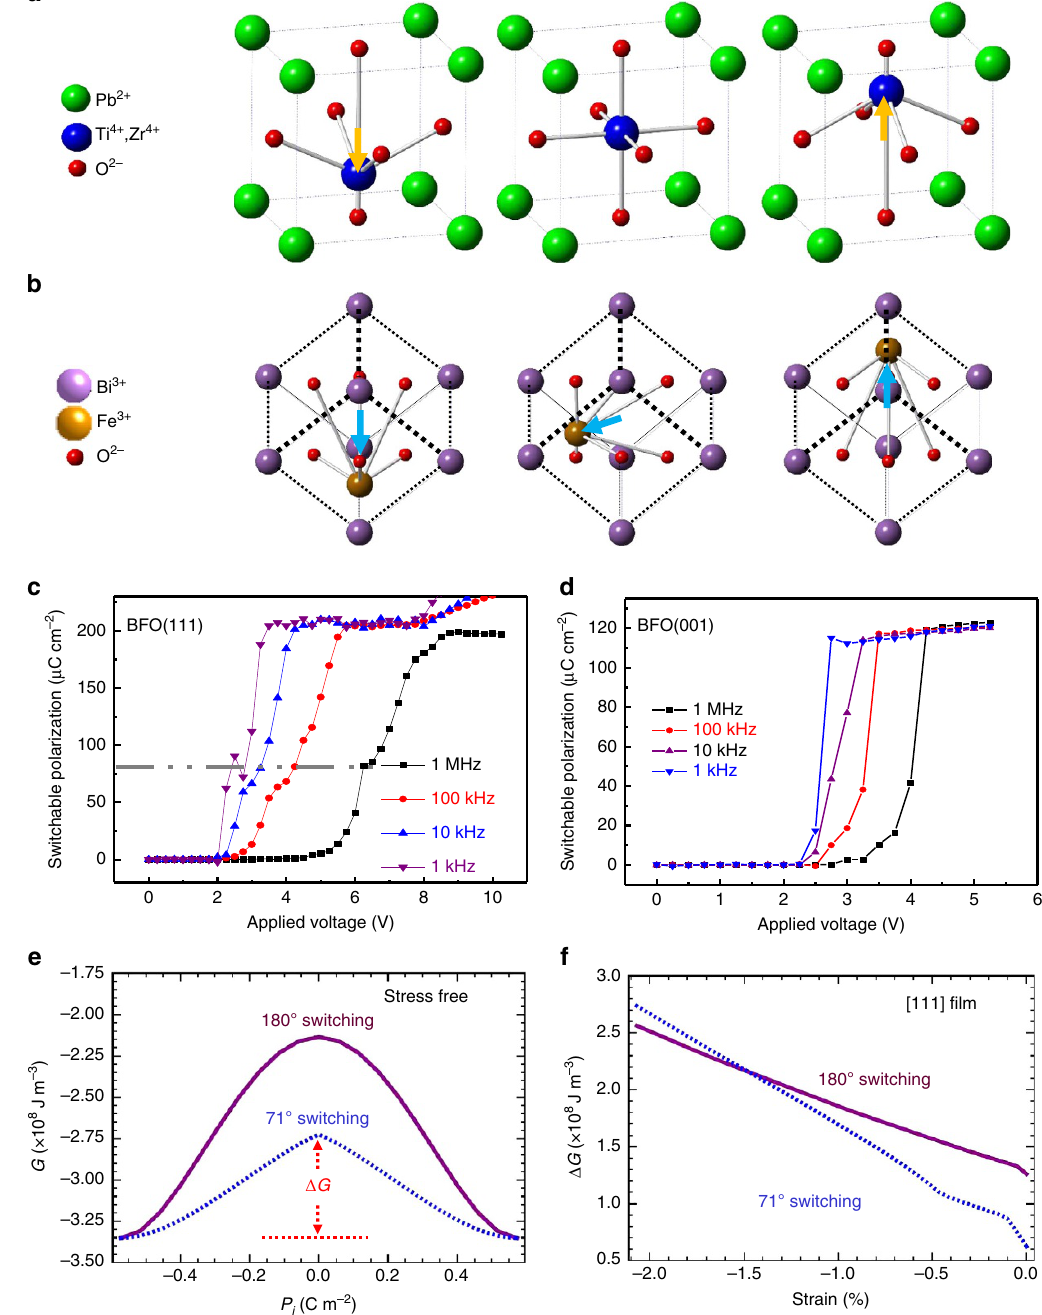
Figure 1 | The processes of polarization switching and simulation of the effect of strain to polarization switching. Schematic diagrams of polarization switching process for ( a ) PZTand ( b ) BFO(111), and the polarization–electric field PE loops for ( c ) BFO(111) and ( d ) BFO(001). ( e ) Total free energy as a function of switching path under stress-free boundary conditions. In 71 (cid:2) switching, the polarization direction is changed from [111] to ½ 11 (cid:2) 1 (cid:3) through [110], whereas in 180 (cid:2) switching, the polarization direction is switched from [111] to ½ (cid:2) 1 (cid:2) 1 (cid:2) 1 (cid:3) through [000]. ( f ) Energy barrier as a function of epitaxial strain in (111) BFO films. The arrows in ( a , b ) represent the direction of displacement of the central atoms (Ti 4 þ , Zr 4 þ in PZT and Fe 3 þ in